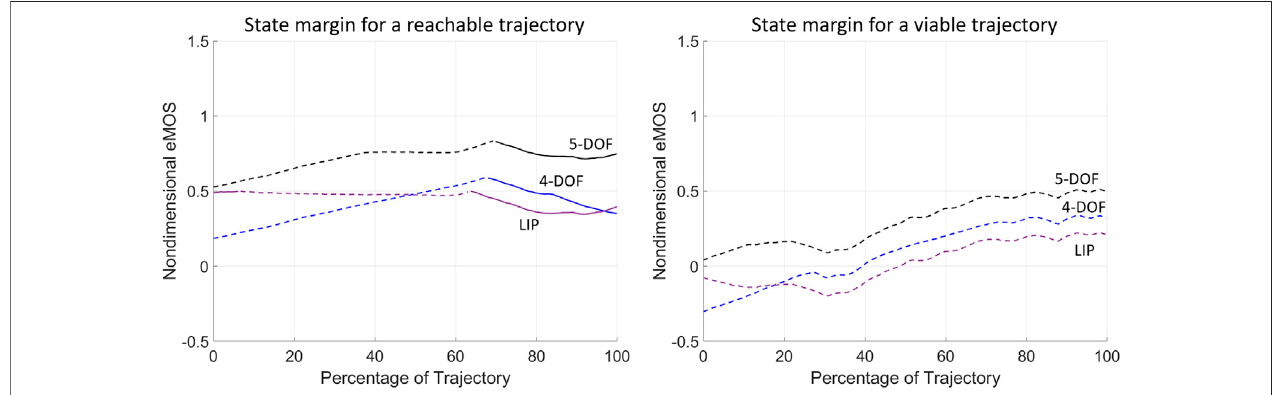
FIGURE 7 | The instantaneous state margin (eMOS) is calculated throughout the balancing motion of the two example trajectories from (Patton et al., 1999). The eMOS values are calculated for the normalized trajectories and BoB of each biped model considered, where the solid and dashed lines correspond to state margins relative to the upper and lower BoB lines,